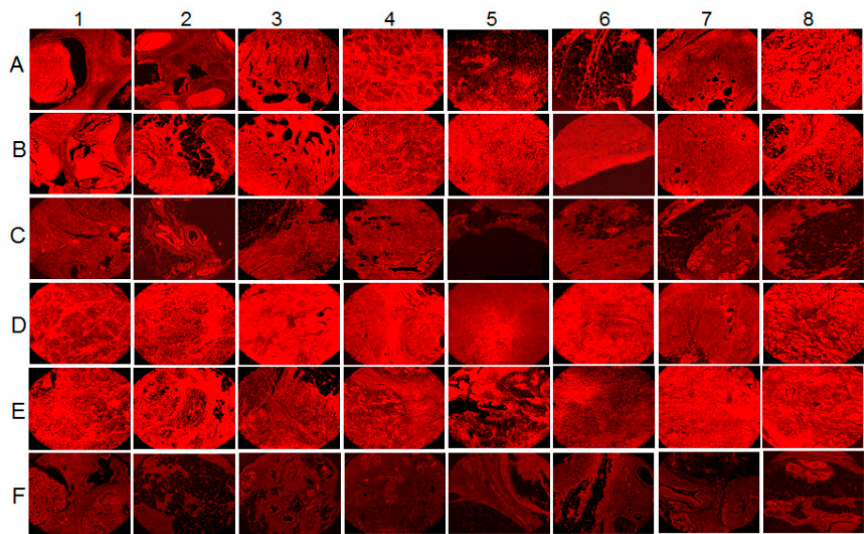
Figure 5. Fatty acid synthase (FASN) levels in human breast cancer tissue samples. 16 breast cancer tissue samples, in duplicates ( A , B , D , E ) along with their controls ( C , F ) were analyzed by IHC staining for FASN. Magnification for the panels is 4×.